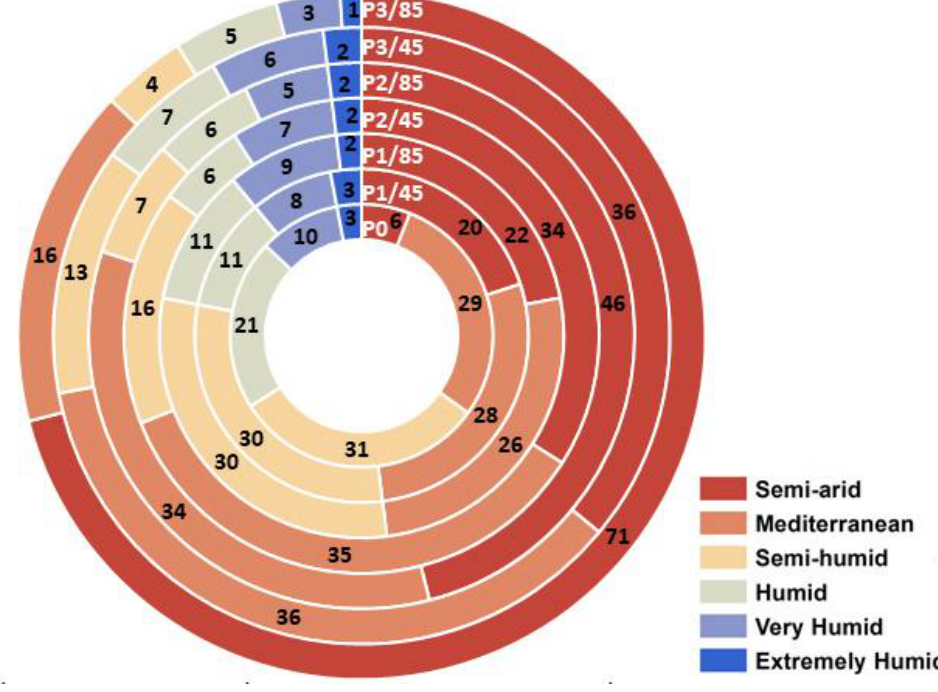
Figure 7. Percentage of each De Martonne aridity index class considering the baseline period (P0), 1971 – 2005, the near future (P1), 2006 – 2035, the mid-century (P2), 2036 – 2065, and the end of the century (P3) 2066 – 2095, under two different scenarios, RCP4.5, and RCP8.5.